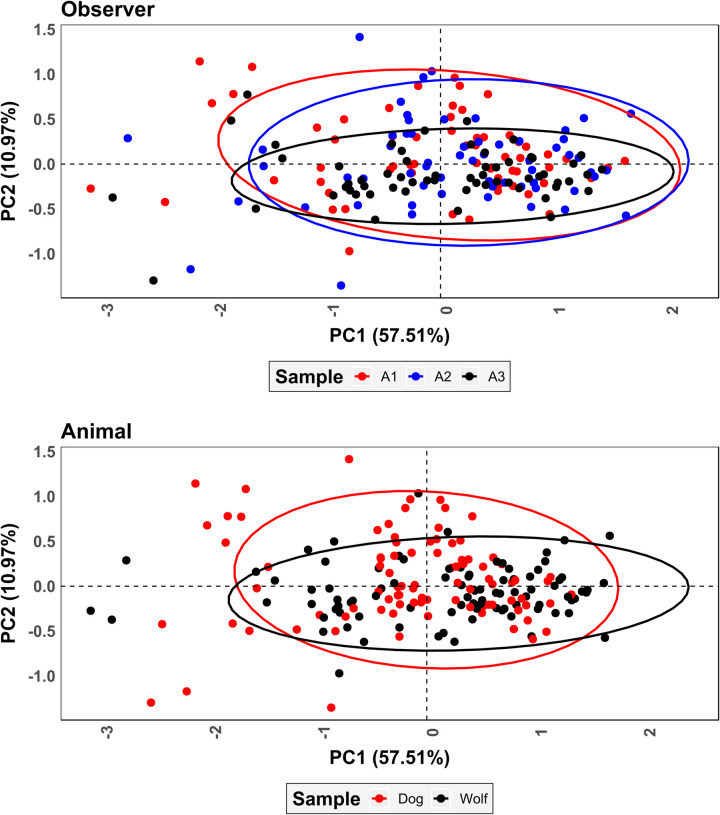
Scatter plot of principal components analysis results for partially superimposed landmark coordinates.Ellipses represent 95% confidence intervals.